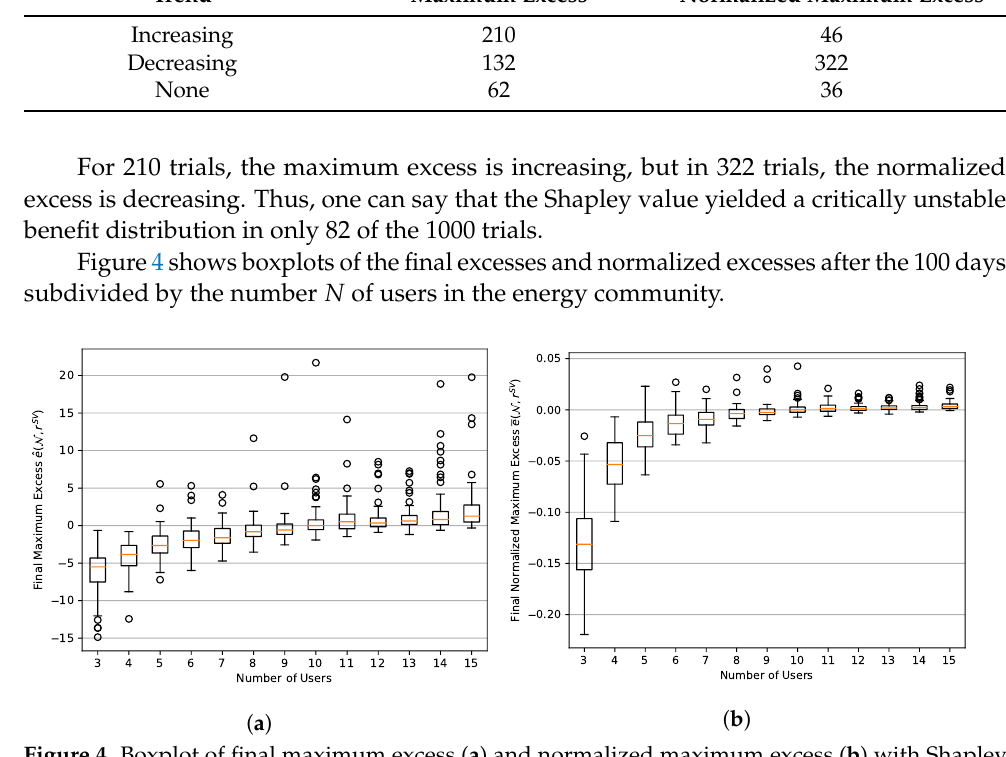
Table 2. Numbers of unstable trials with increasing, decreasing, and no trend in the excess and normalized excess between day 20 and 100 with Shapley value benefit distribution. Trend Maximum Excess Normalized Maximum Excess Increasing 210 46 Decreasing 132 322 None 62 36